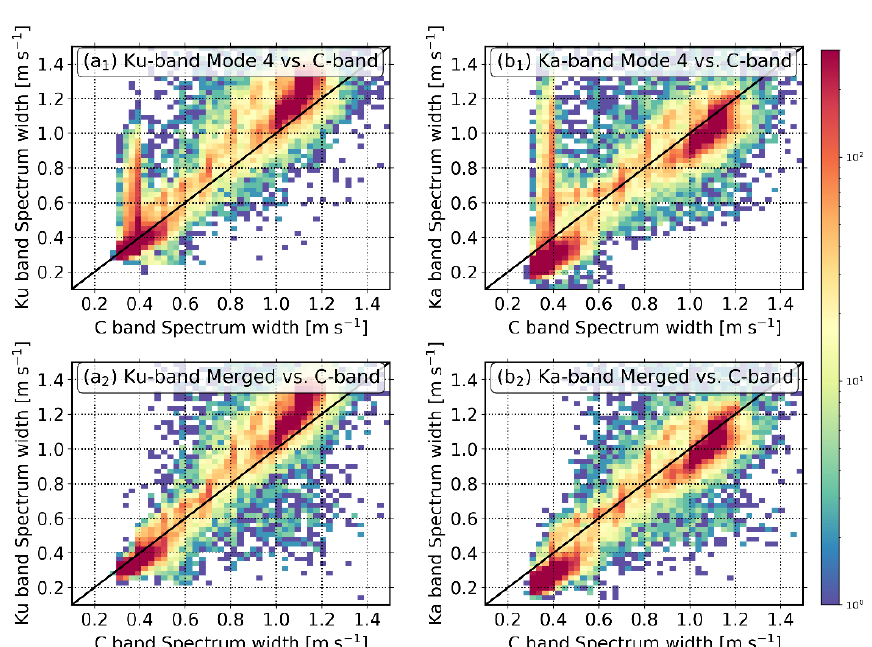
Figure 16. Same as Fig. 15 but at Ka band.